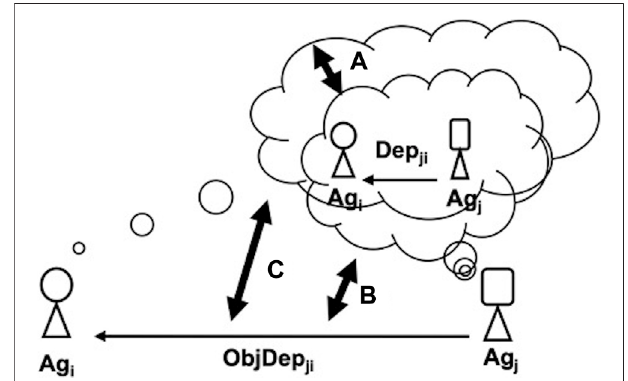
FIGURE 4| : Dependence of Ag j from Ag i on the task τ ’ . (A) comparison onhowitisbelievedbyAg i andbyAg j ; (B) comparisononhowitisbelievedby Ag i and objective reality; (C) comparison on how it is believed by Ag j and objective reality.